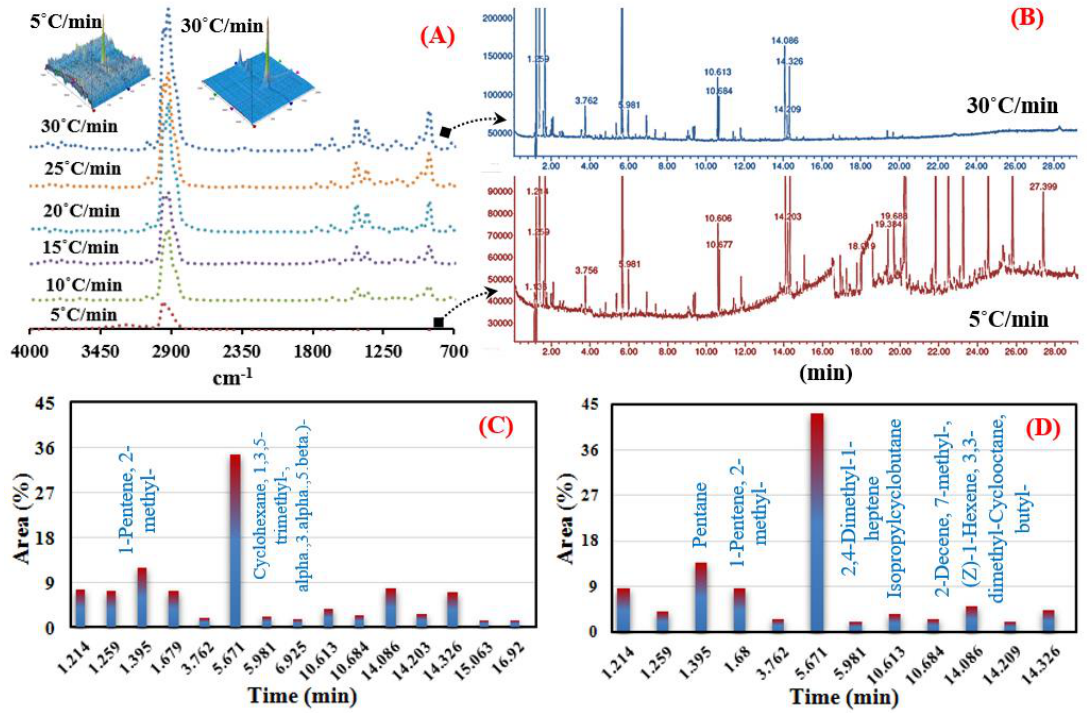
Figure 2. ( A ) 2D-3D FTIR analysis, ( B ) GC-MS analysis at 5 and 30 °C/min, and ( C,D ) the obtained GC-MS compounds at 5 and 30 °C min −1 .